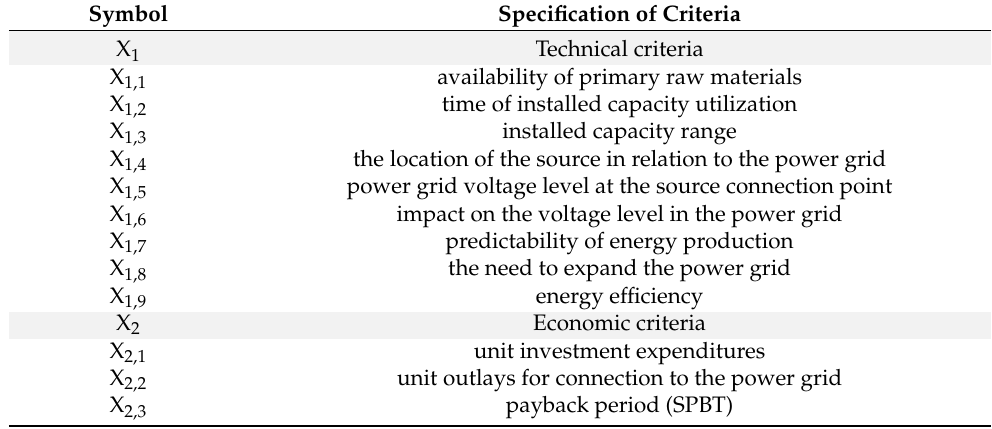
Table 1. A set of criteria used to evaluate RES